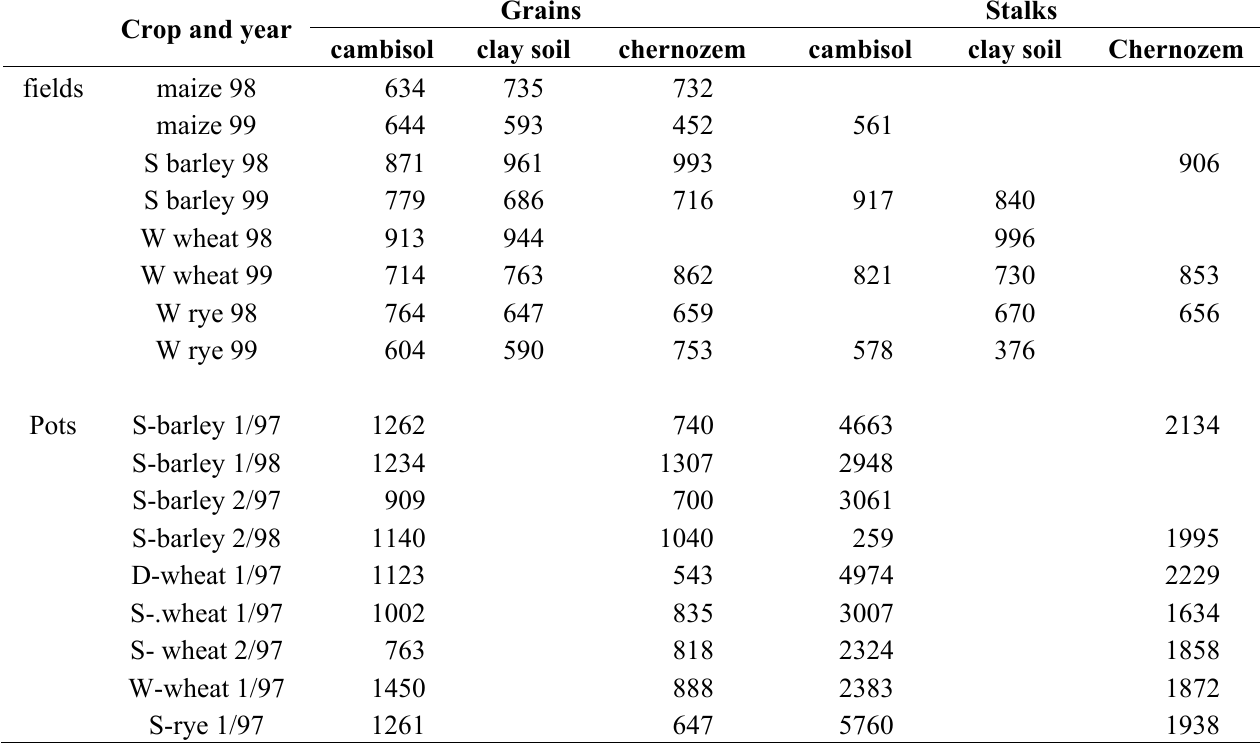
Table 3. Results for the field experiments, means of total sulfur contents in mg/kg (from [7]). Grains Stalks Crop and year cambisol clay soil chernozem cambisol clay soil